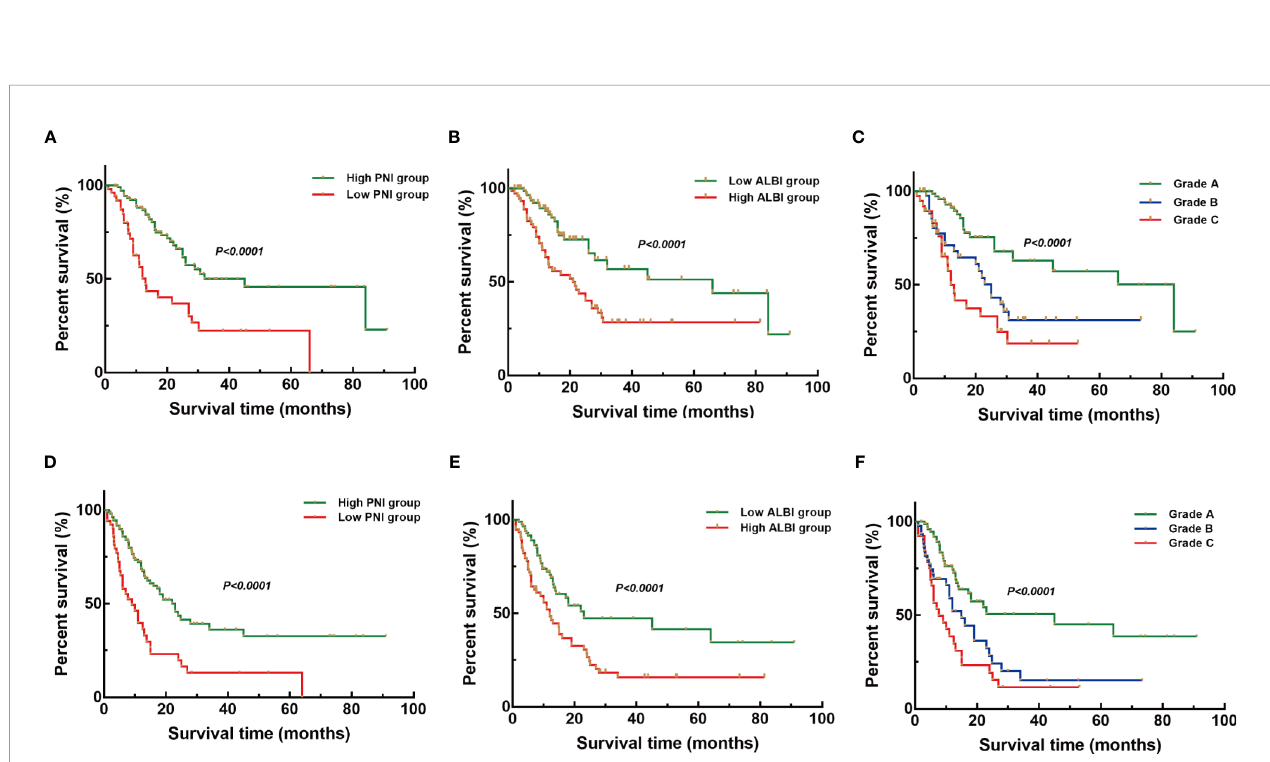
FIGURE 2 | Kaplan – Meier overall survival (OS) and recurrence-free survival (RFS) curves of patients with intrahepatic cholangiocarcinoma (ICC) after radical resection according to different prognostic factors in the testing set. (A – C) Kaplan – Meier OS curves according to the prognostic nutritional index (PNI) (A) , albumin – bilirubin (ALBI) (B) , and PNI+ALBI grade (C) . (D – F) Kaplan – Meier RFS curves according to PNI (D) , ALBI (E) , and PNI+ALBI grade (F)